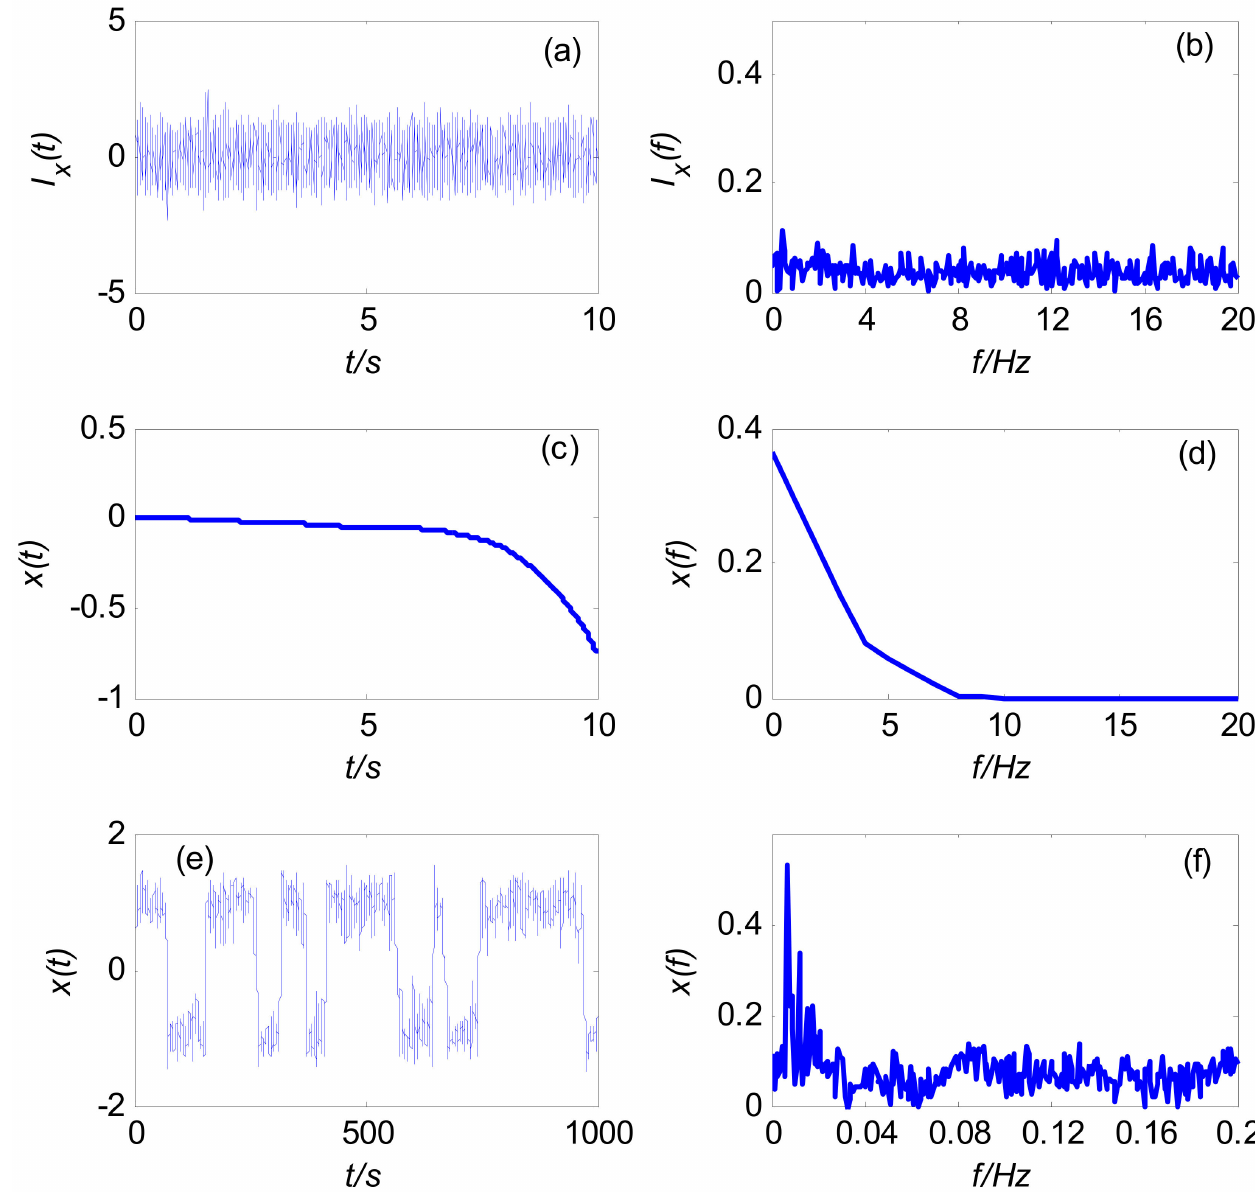
Figure 5. SR of the measurement signal with noise: ( a ) waveform of the input signal; ( b ) spectrum of the input signal; ( c ) waveform of the output signal; ( d ) spectrum of the output signal; ( e ) waveform of the output signal based on a variable scale; ( f ) spectrum of the output signal based on a variable